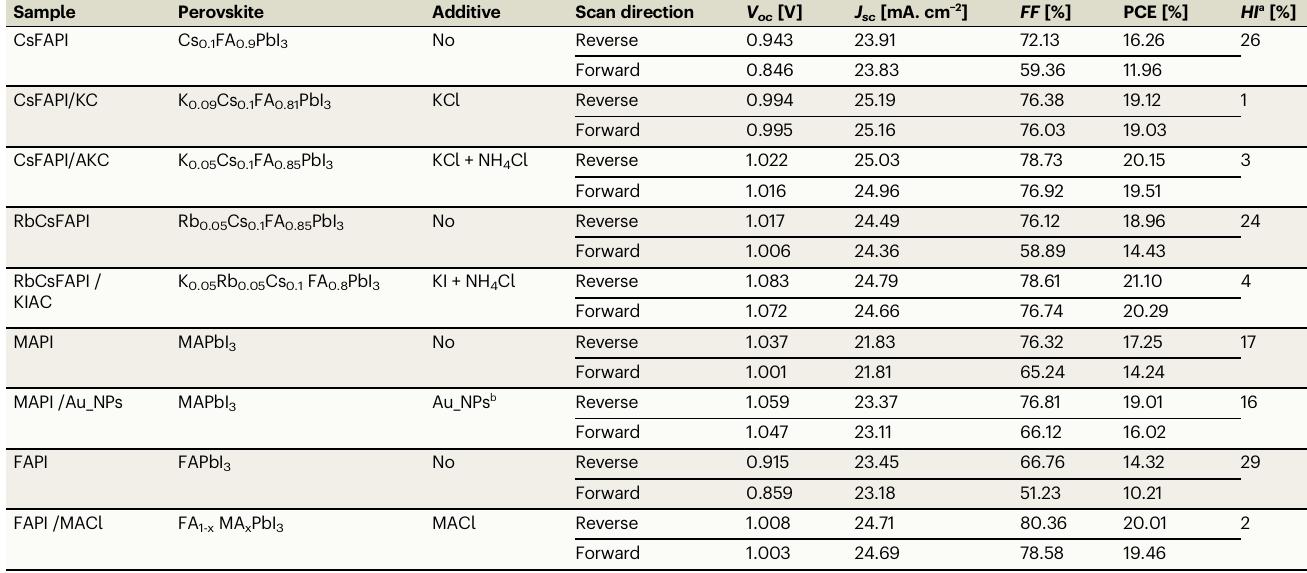
Perovskitecomposition, additive, J-V curve parameters, PCE and hysteresis index of champion solar cells.Noperovskite surface treatment. a Hysteresis Index, notedHI, de fi ned as (PCE Rev − PCE For )*100/PCE Rev . b Au_NPs: Gold